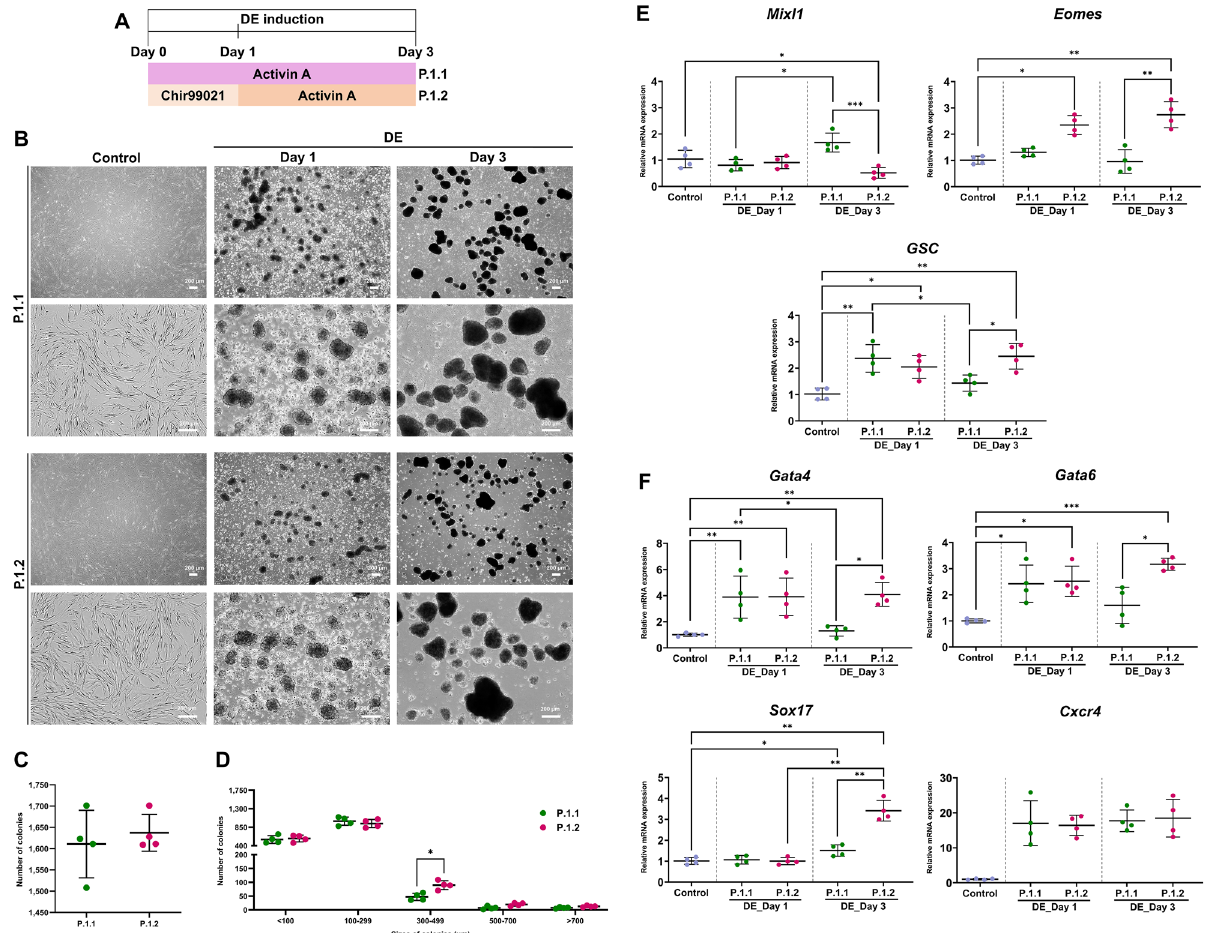
Figure 2. Generation of cAD-MSC-derived DE cells. The diagrams of two protocols used for the induction of cAD-MSC derived DE cells are shown in ( A ). Differentiation of morphological appearances of cAD-MSCs toward DE cells was observed at day 1, and 3 ( B ). The total colony number ( C ) and the distribution of colony sizes ( D ) were evaluated. The expression of mRNA markers relating to mesendoderm status ( E ), and definitive endoderm status ( F ) was analyzed by RT-qPCR at day 1, and 3 post-induction. Relative mRNA expression was normalized with the reference gene, and the undifferentiation control. Bars indicates the significant differences (*, p value < 0.05; **, p value < 0.01; ***, p value <